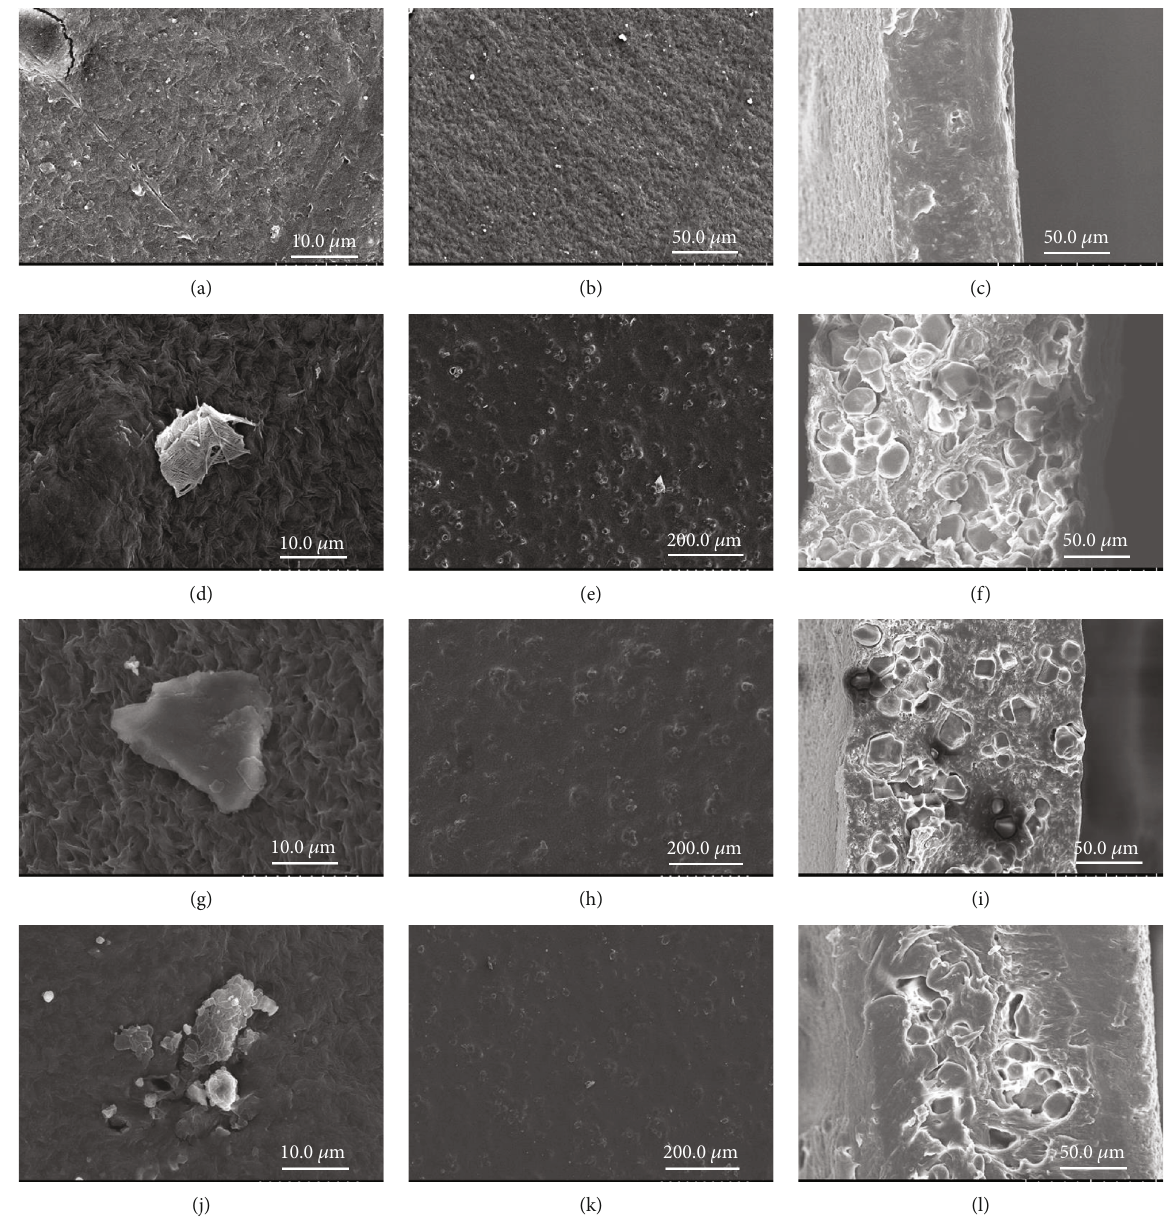
Figure 2: SEM images of PHB/S/LA blends at di ff erent magni fi cations. Pure PHB at 10.0 μ m (a) and 50.0 μ m (b) and cross-section at 50.0 μ m (c). LA0 at 10.0 μ m (d) and 200.0 μ m (e) and cross-section at 50.0 μ m (f). LA1 at 10.0 μ m (g) and 200.0 μ m (h) and cross-section at 50.0 μ m (i). LA2 at 10.0 μ m (j) and 200.0 μ m (k) and cross-section at 50.0 μ m